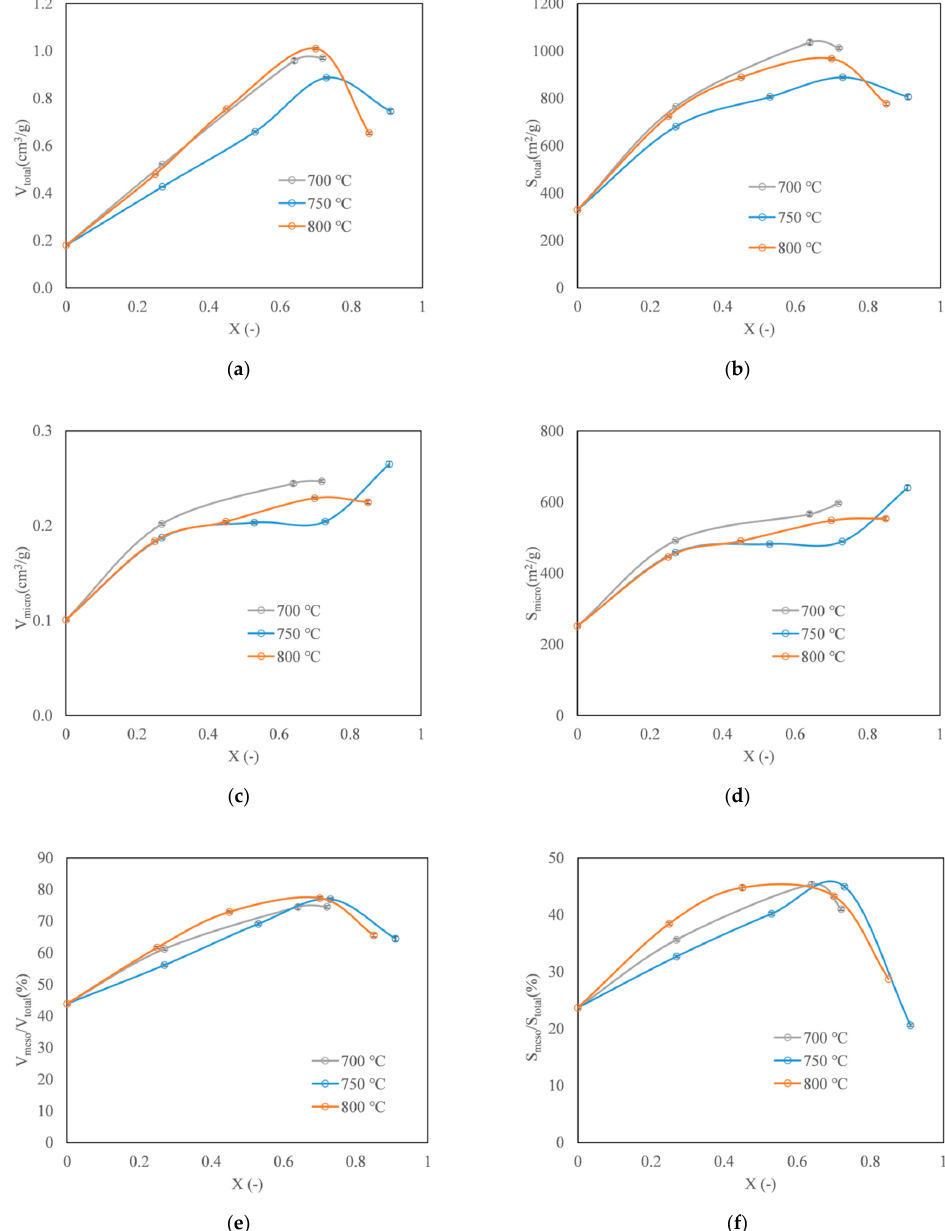
Figure 6. Textural properties of the OC at different temperatures with different conversions for original char. Left: pore volume versus conversion at different temperatures. Right: Specific surface area versus conversion at different temperatures. (The relative error is minor and is not shown in the figure.) ( a ) the total pore volume versus conversion; ( b ) the total specific surface area versus conversion; ( c ) the micropore volume versus conversion; ( d ) the micopore surface area versus conversion; ( e ) the mesopores volume fraction versus conversion; ( f ) the mesopore area fraction versus conversion;